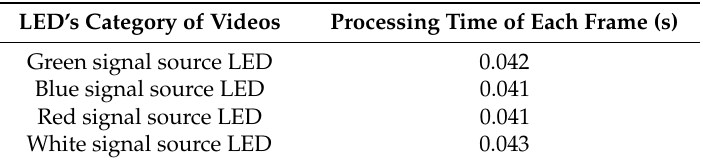
Table 2. Results of real time